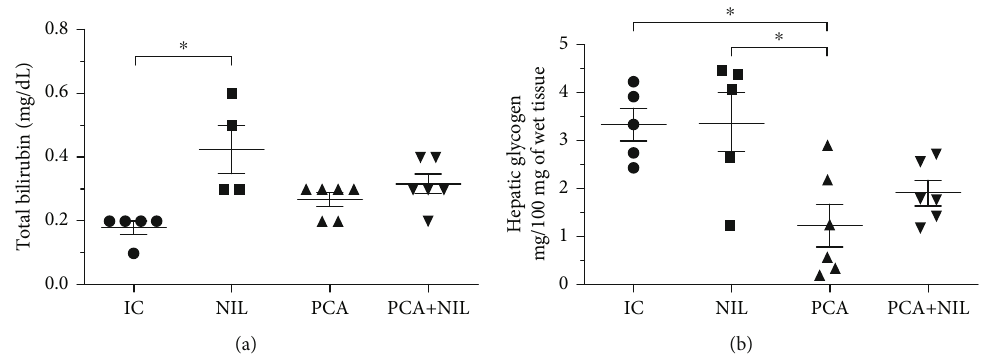
Figure 3: E ff ects of neurointermediate pituitary lobectomy (NIL), portacaval anastomosis (PCA), and PCA+NIL on (a) total bilirubin serum levels and (b) hepatic glycogen. ∗ p < 0 : 05 IC vs. NIL. The intact control (IC) group served as reference. It was evaluated with analysis of variance test with the Tukey post hoc values, which are expressed as the mean ± SD .